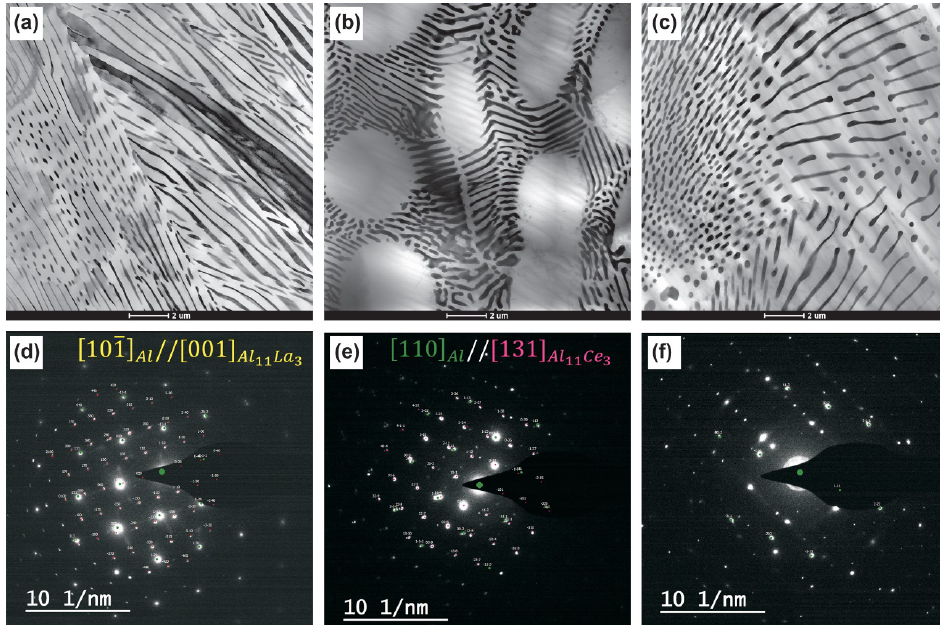
Figure 2. Bright-field TEM images and corresponding SAED patterns of as-cast alloys microstructure: ( a , d ) Al–10% La; ( b , e ), Al–9% Ce; ( c , f ) Al–7% Ni.